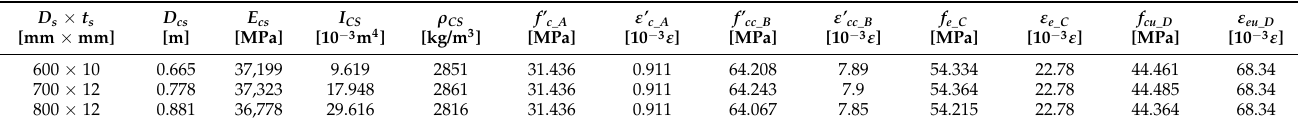
Table 6. Equivalent geometries and constitutive model for the confined